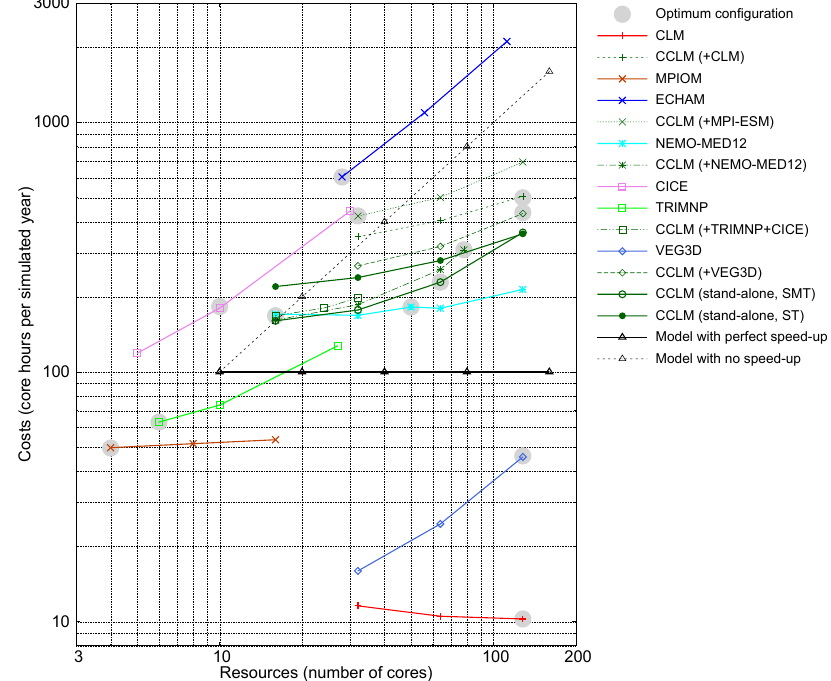
Figure 4. As Fig. 3 but for the cost of the components in core hours per simulated year.